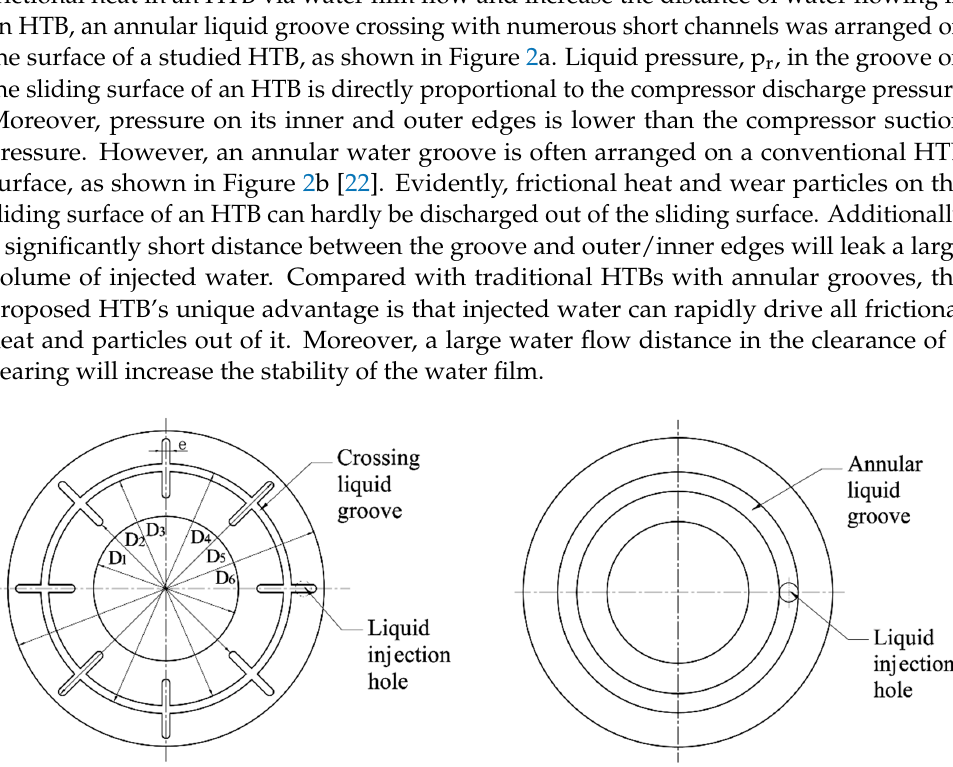
Figure 3. Workflow of the methodology. 2. Methodology 2.1. Force Analysis and Parameters of the HTB 2.1.1. Determination of Forces Acting on a Star Wheel The HTB force used for the star wheel shaft is related to the force of the star wheel. Thus, the force analysis of the star wheel is also the focus of the research on an HTB’s working characteristics. Forces acting on a star wheel mainly come from the action of gas pressure in the cylinder and constricting forces exerted by bearings on them. Illustrations of the acting forces and torques are shown in Figure 4.